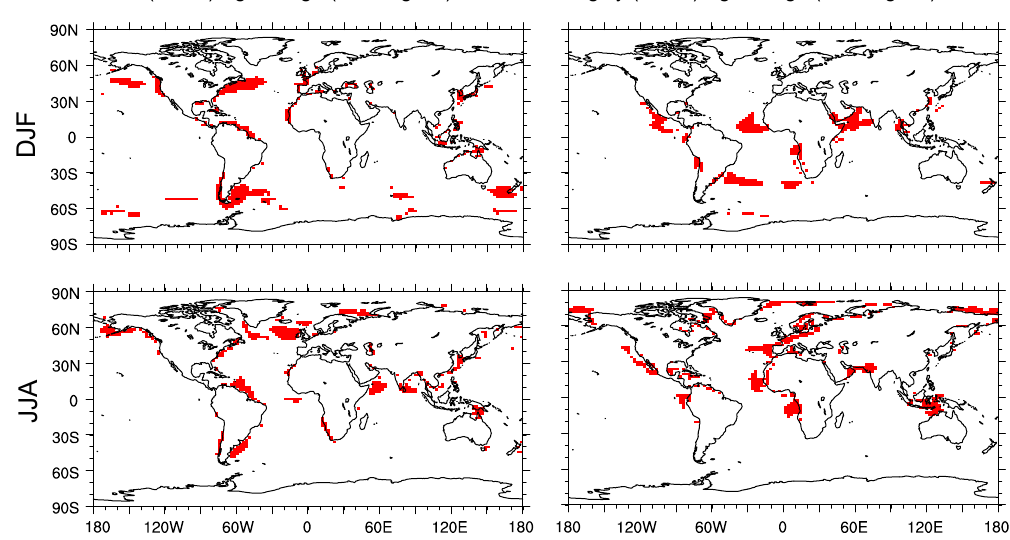
Figure 5. Regions (in red) with GEOS-Chem-predicted seasonal submicron MOA concentrations > 200ngm − 3 for both low-aged (left column, < 40% hydrophilic marine organic aerosol) and highly aged (right column, > 60% hydrophilic marine organic aerosol)